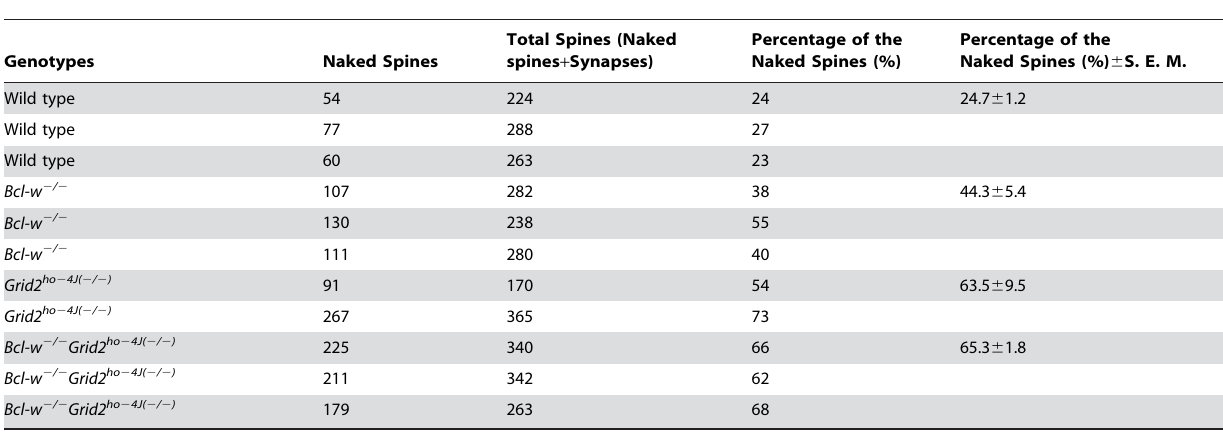
Table 1. Percentage of Naked Purkinje Cell Spines in Total Spines in Wild Type, Bcl-w 2 / 2 , Grid2 ho 2 4J( 2 / 2 ) , and Bcl-w 2 / 2 Grid2 ho 2 4J( 2 / 2 ) Mice.